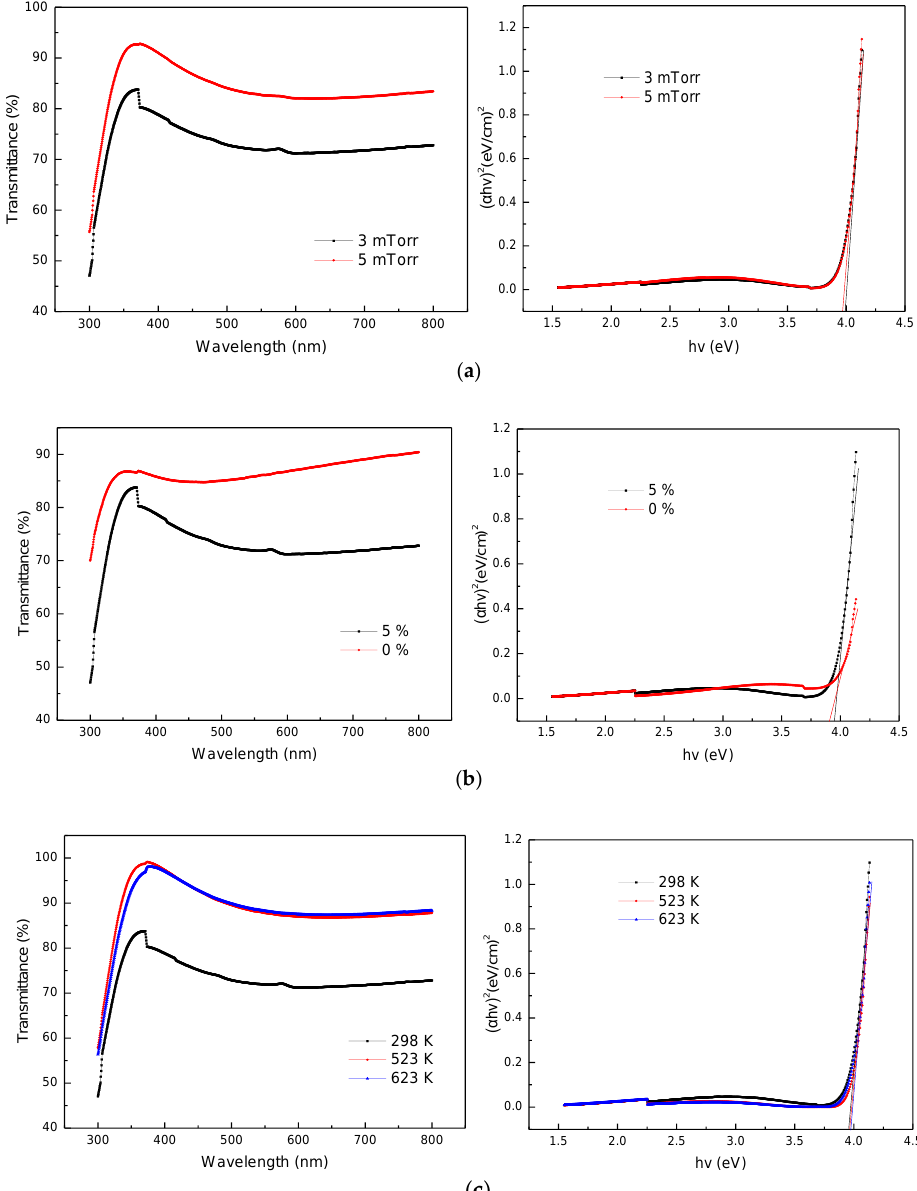
Figure 3. Optical transmittance spectra and ( α h v )² versus h v plots of ZATO films: ( a ) Different gas pressure (at 5% oxygen content and unannealed), ( b ) different oxygen/argon ratios (at 3 mTorr and unannealed) and ( c ) different annealing temperatures (at 3 mTorr and 5% oxygen/argon ratio).